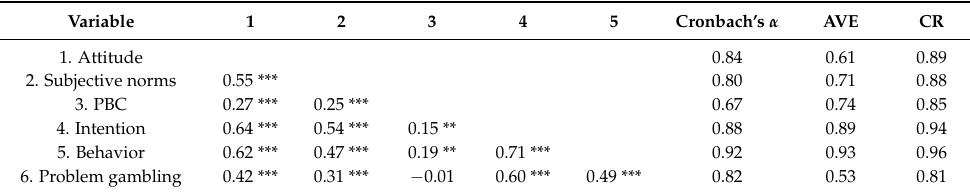
Table 1. Correlations, reliability and